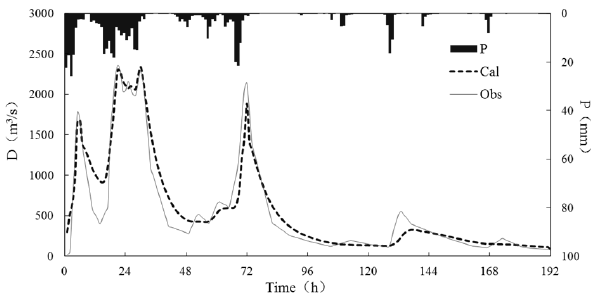
Figure 6. Comparison of the calculated results and observed flood No. 860715.